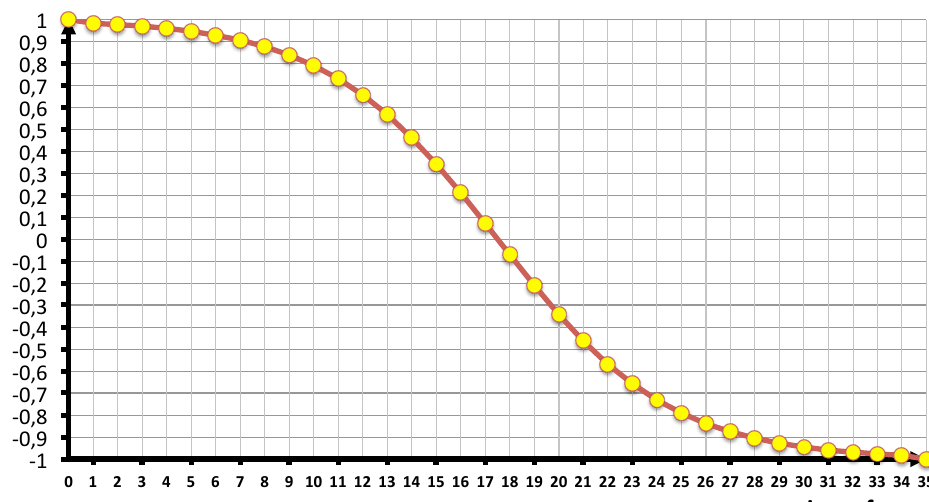
Figure 20. Fuzzy characteristic function µ RiskAfterSurgery ( H ( x ) of PE. Evolutionary Variables - Hemoptysis Hemoptysis is defined by its presence or absence. When present, risk is high if the hemoptysis was frank, moderate if it was blood-striped sputum, and none in the